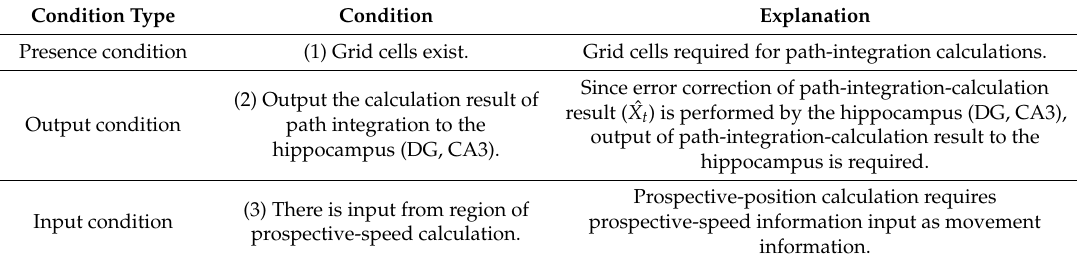
Table 3. Required conditions for executing path-integration